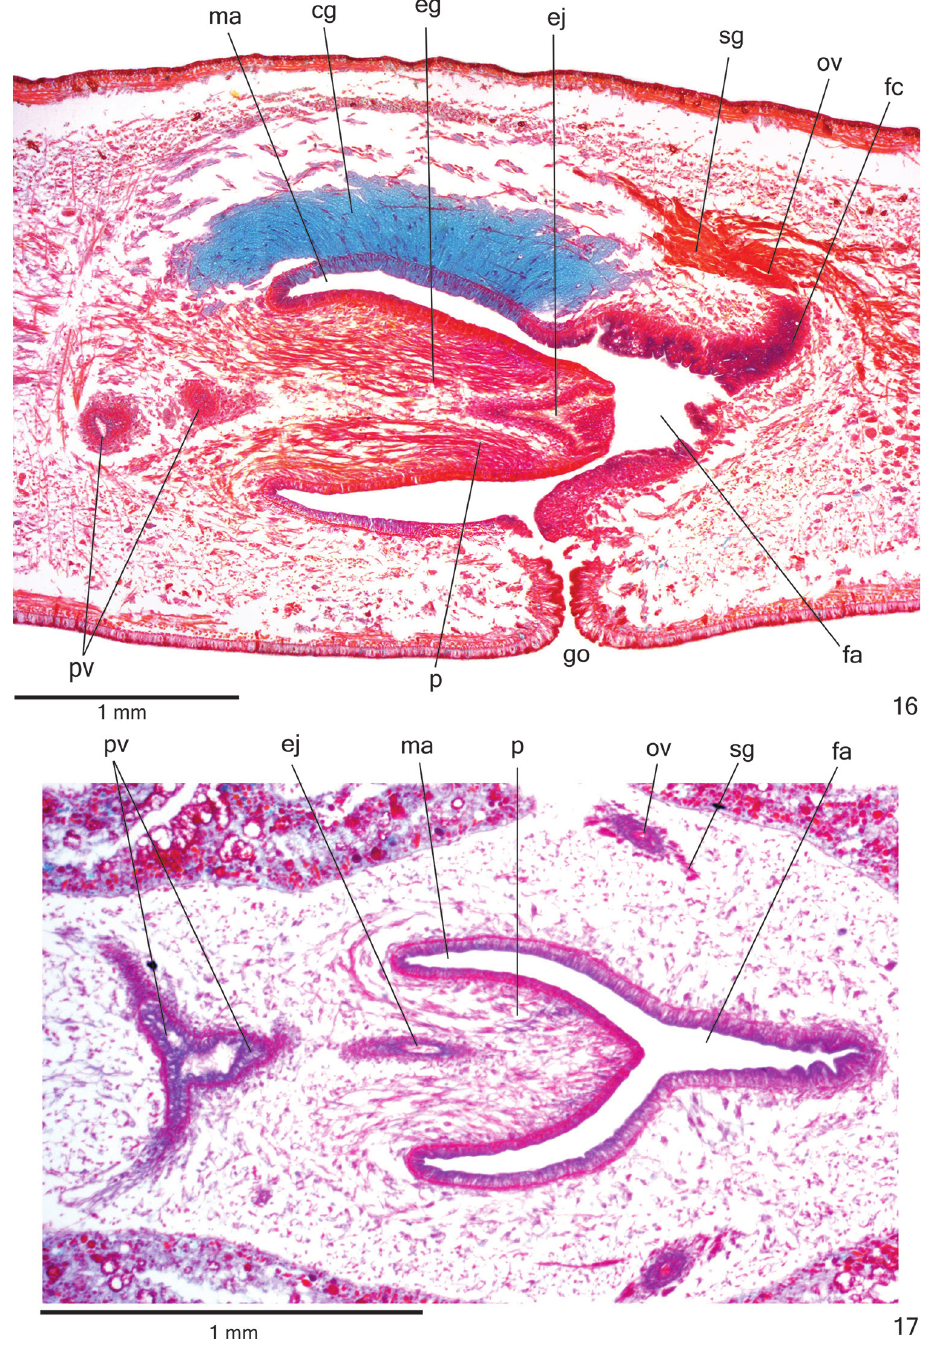
Figures 16–17. Cratera cryptolineata sp. n., 16 holotype, copulatory apparatus, sagittal section 17 specimen MZU PL.00219, copulatory apparatus, horizontal